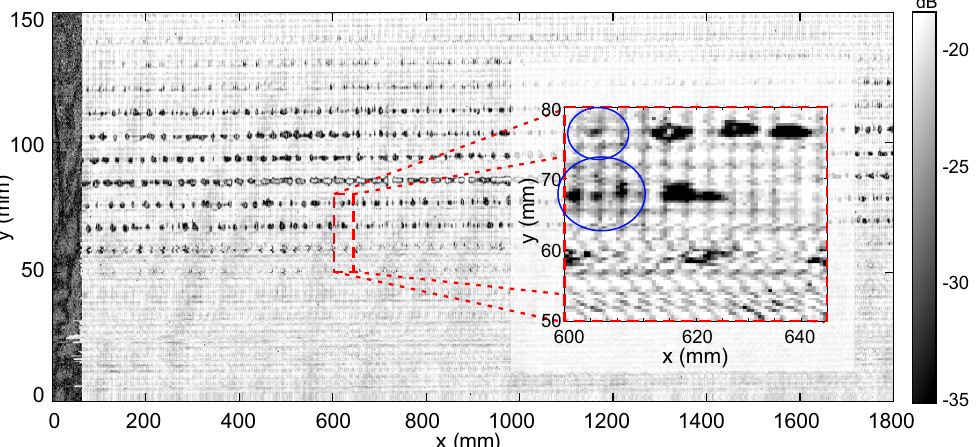
Figure 7. Terahertz image of a press sleeve measured under real operation conditions (150 rpm rotational speed, sleeve diameter 1.3 m) with the 500 GHz FMCW transceiver. The production conditions were deliberately altered during manufacturing to produce this high density of defects in the investigated area. The image shows again only a segment of 1800 × 150 mm 2 out of the total scan area of 1.2 mm 2 for better visibility. Clearly, defects of various sizes are revealed to dimensions down to less than the grid spacing of approximately 1 mm of the visible fiber mesh pattern (see blue circles in the magnified inset). The black area on the left of the image represents the shadow of the attached metal strip on the sleeve’s surface for the alignment of the continuously recorded terahertz